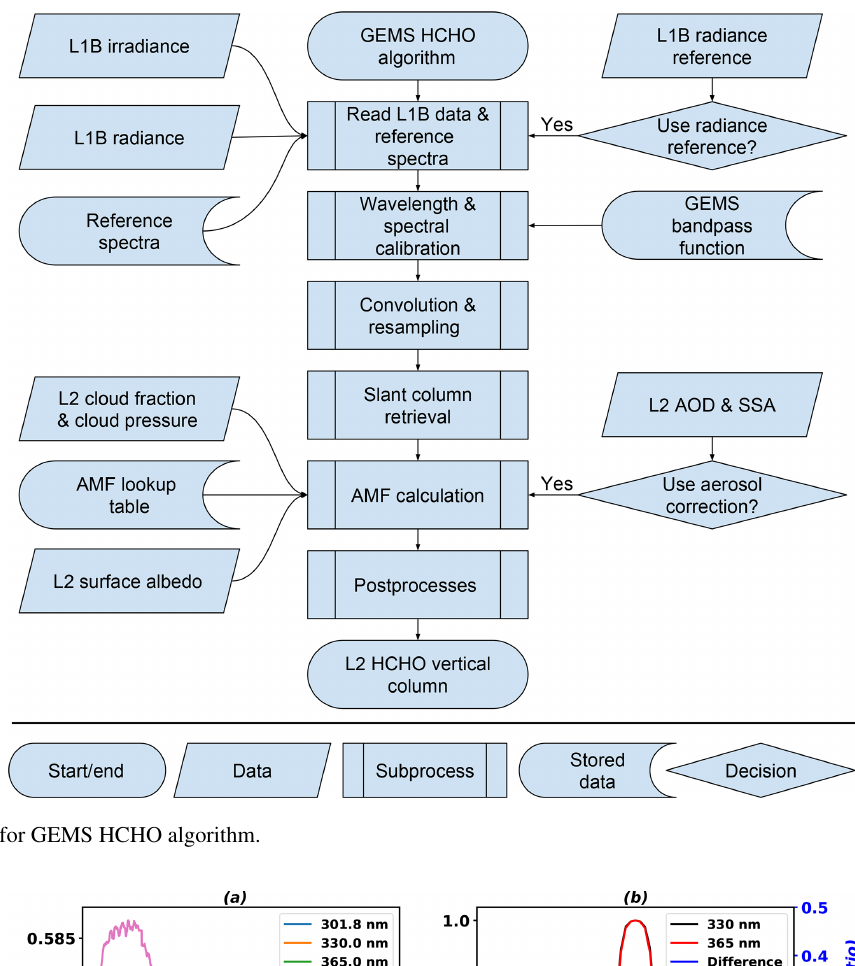
Figure 2. Flow chart for GEMS HCHO algorithm.